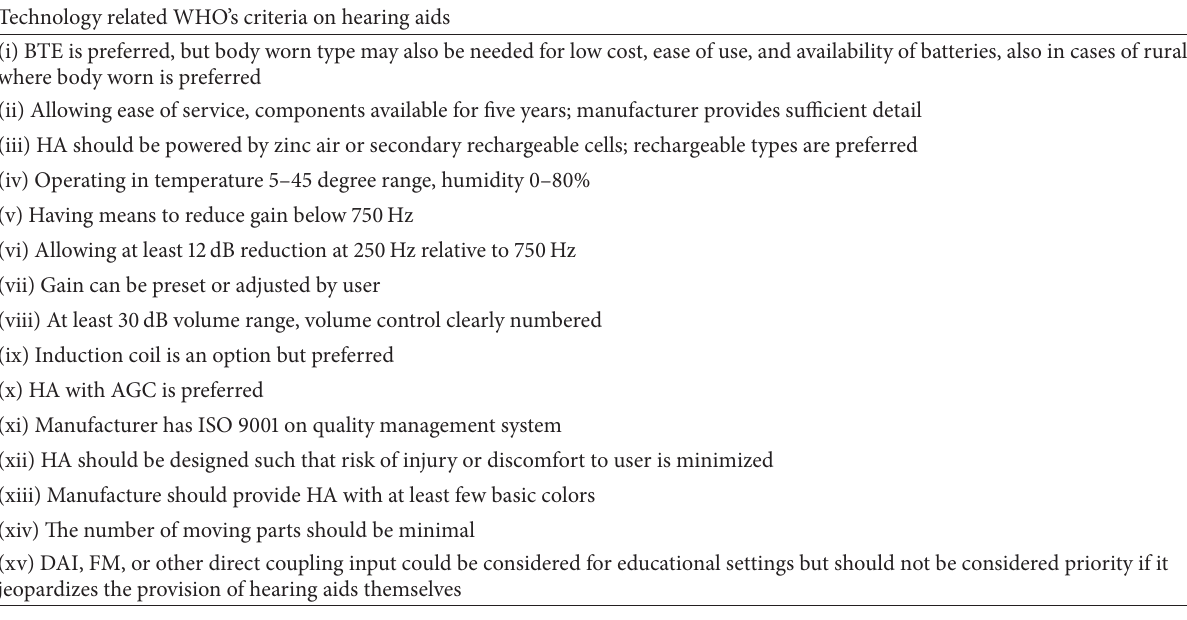
Technology related WHO’s criteria on hearing